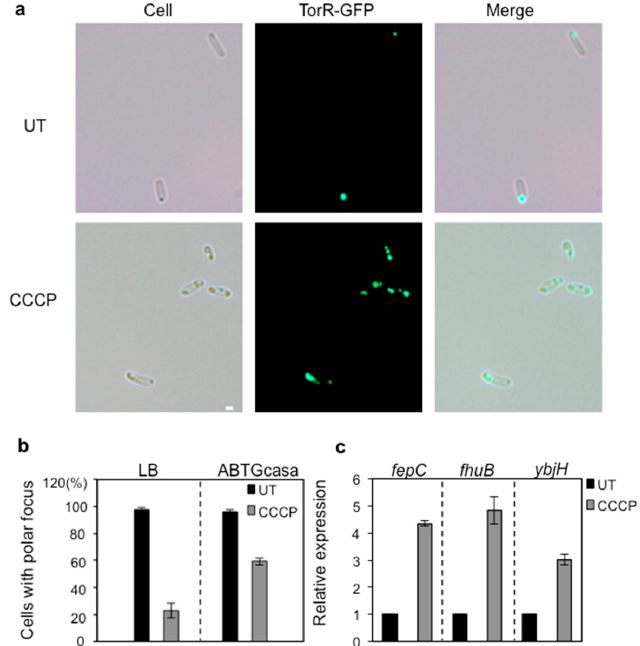
Figure 5. Polar localization and regulatory function of TorR ‐ GFP on gene expression are dependent on ATP. ( a ) W3110 Δ torR /pTorR ‐ GFP cells were exponentially grown in LB with IPTG for expression of TorR ‐ GFP at 37 °C. The cells were treated or untreated with 100 μ M carbonyl cyanide 3 ‐ chlorophenylhydrazone (CCCP) at OD 450 = 0.25 for 5 min to abolish ATP synthesis, and fixed in 70% ethanol. TorR ‐ GFP visualization was as described in the legend to Figure 1. The top panels are for cells untreated, shown as UT for short; lower panels are for cells treated with CCCP. The scale bar represents 1 μ m; ( b ) Exponentially growing W3110 Δ torR /pTorR ‐ GFP cells in LB or ABTGcasa at